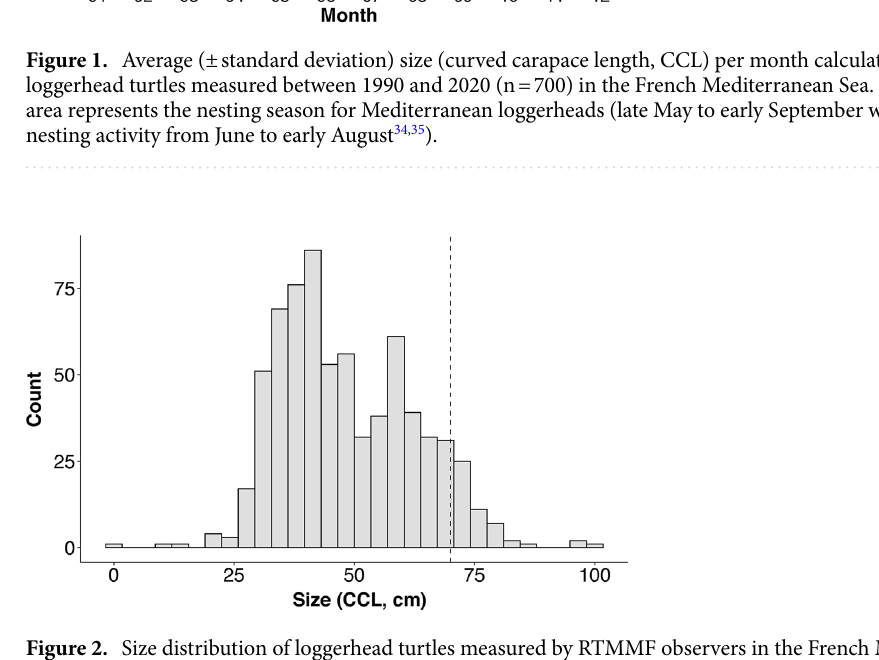
Figure 2. Size distribution of loggerhead turtles measured by RTMMF observers in the French Mediterranean Sea between 1990 and 2020. The dashed line indicates the 70 cm CCL (curved carapace length) threshold beyond which individuals are considered to be sexually